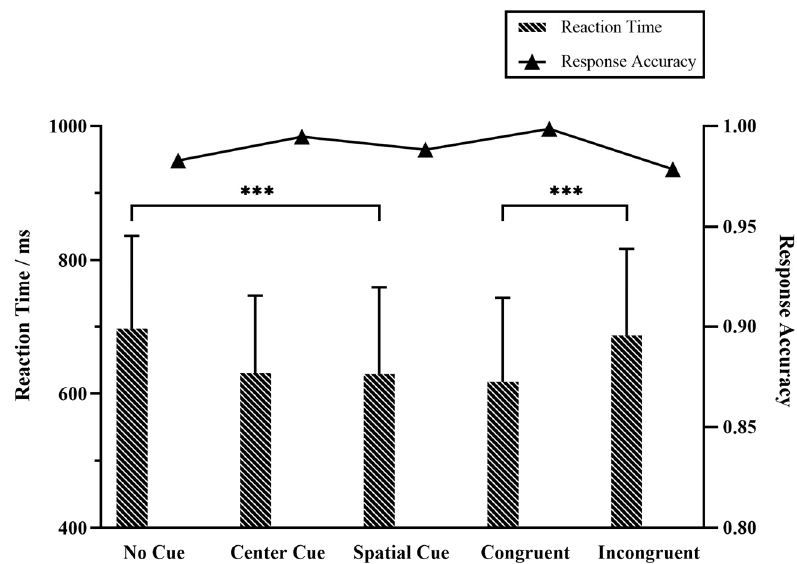
Figure 4. Behavioral main effects for reaction time and response accuracy during EEG recording. *** represented the significance p < 0.001 with repeated ANOVA test, and the error bars indicated the standard error of the mean.